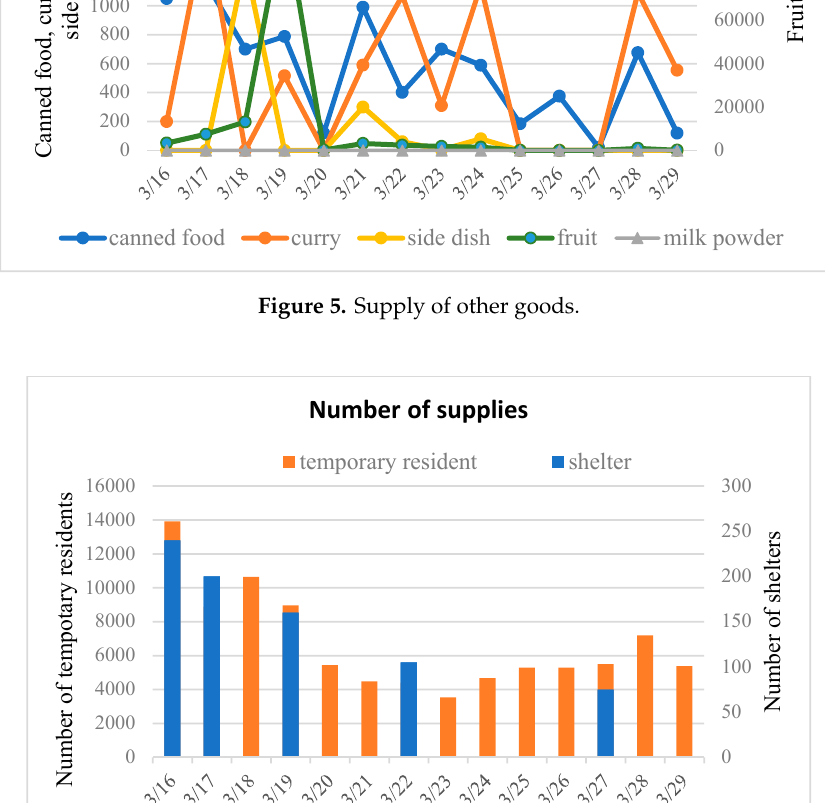
Figure 6. Number of temporary shelters and residents.